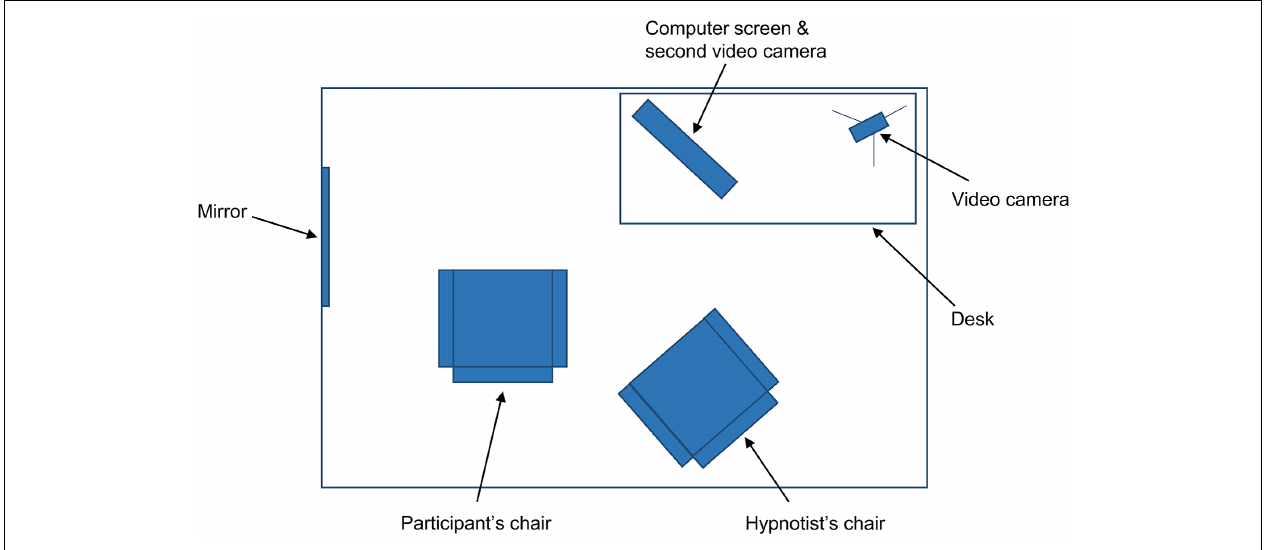
FIGURE 1 |Topographical view of materials in the experiment. The mirror was covered with a screen when the participant entered the room.The computer was positioned at 45 ◦ from the participant’s chair, though the participant could rotate their chair to face the screen directly.